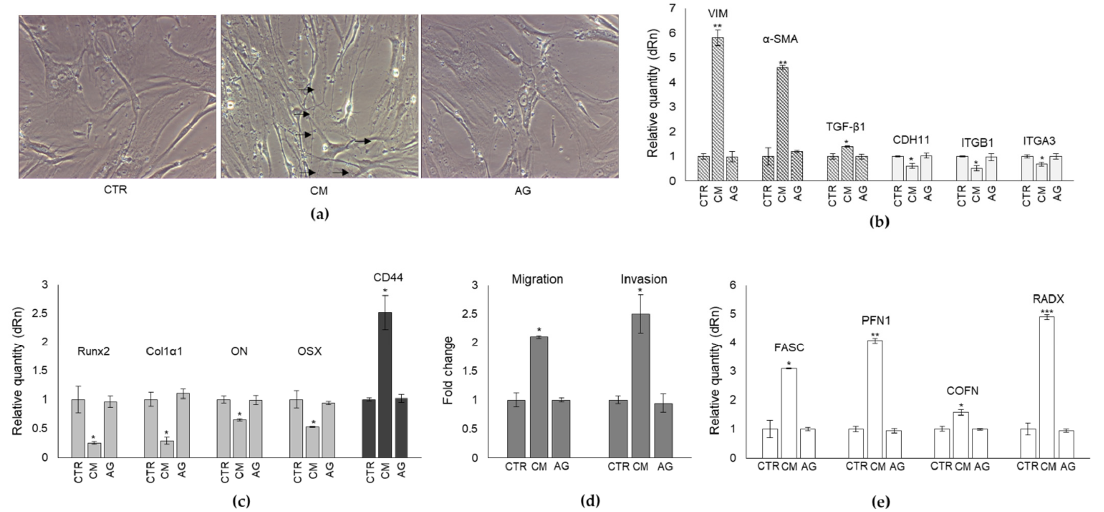
Figure 9. Methylglyoxal (MG)-derived 5-hydro-5-methylimidazolone (MG-H1) is a novel paracrine factor released by bone metastasis-derived PC3 cells to reprogram human osteoblasts (OB) into a mesenchymal-, malignant-like phenotype. ( a ) cell morphology by means of light microscopy, the expression of ( b ) mesenchymal trans-differentiation-associated markers (VIM, α -SMA, TGF- β 1, CDH11, ITGB1, ITGA3), ( c ) markers associated with OB mature phenotype (Runx2, Col1 α 1, ON, OSX) and the pre-osteoblast state marker CD44 ( c ) and ( e ) proteins involved in the formation of filopodia-like protrusions (FASC, PFN1, COFN, RADX) as well as ( d ) migration and invasion were evaluated in OB exposed for 24 h to CM from PC3 cells and to CM from PC3 pre-treated (6 h) with the specific MG scavenger aminoguanidine (AG) (1 mM). Control cells (CTR) represent OB cultured for the same period of time in their specific growth medium. Transcript levels were evaluated by real-time PCR. The histogram indicates the mean ± SD of three different cultures, and each was tested in duplicate. Scale bar = 30 μ m. Arrows indicate filopodium-like protrusions. VIM, vimentin; α -SMA, alpha smooth muscle actin; CDH11, cadherin 11; ITGB1, integrin β 1; ITGA3, integrin α 3; FASC, fascin; PFN1, profilin 1; COFN, cofilin; RADX, radixin. * p < 0.05, ** p < 0.01, *** p < 0.001, versus CTR and AG.